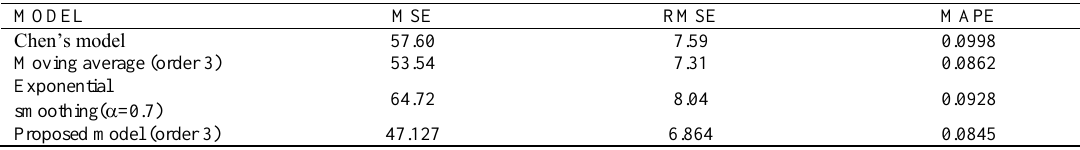
Table 3. Comparative results of testing